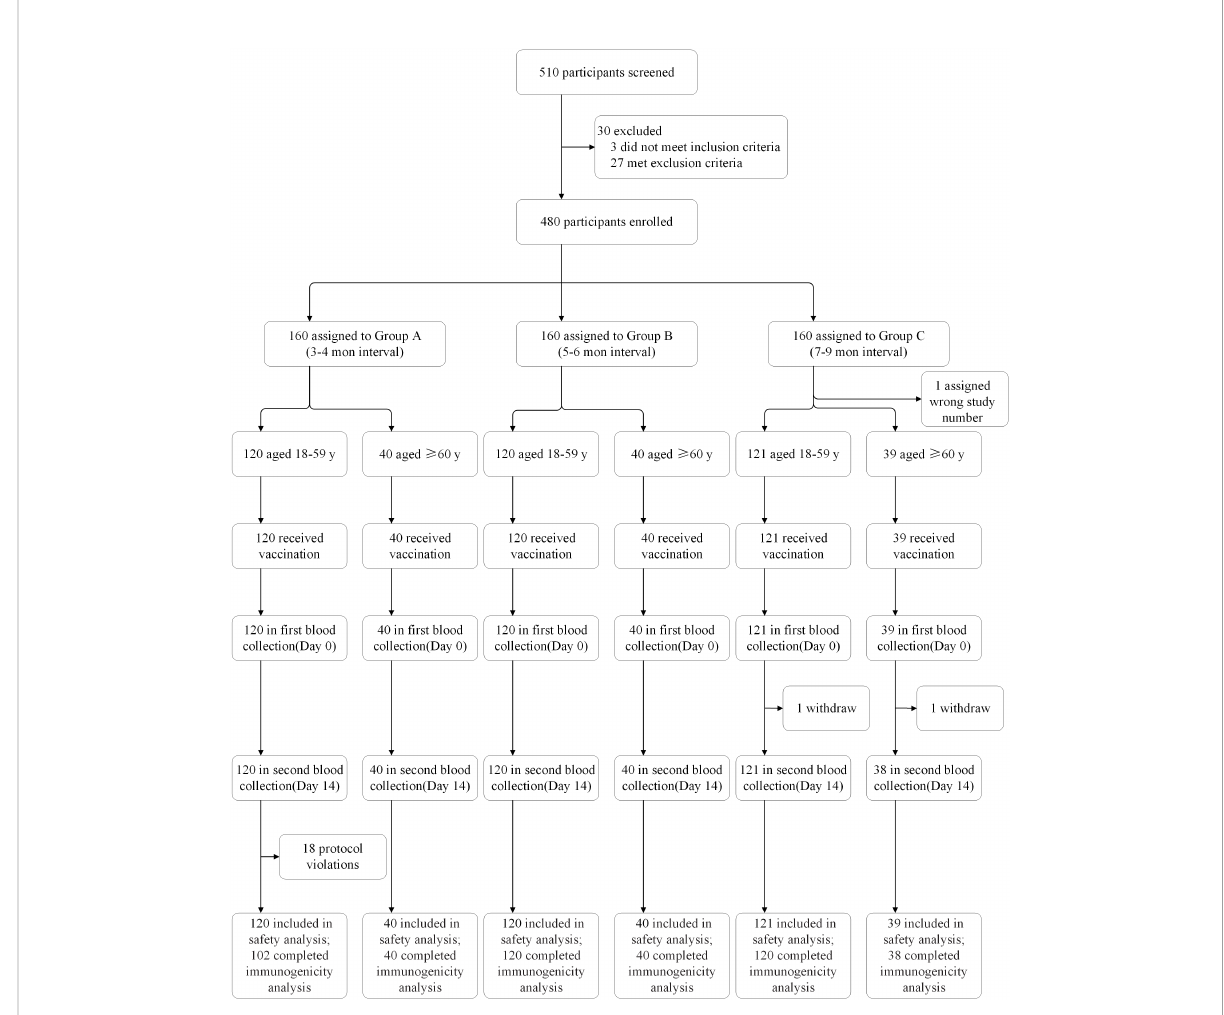
FIGURE 1 Trial pro fi le. Protocol violations: participants who did not receive two doses of CoronaVac, but other inactivated vaccines, were included from the safety